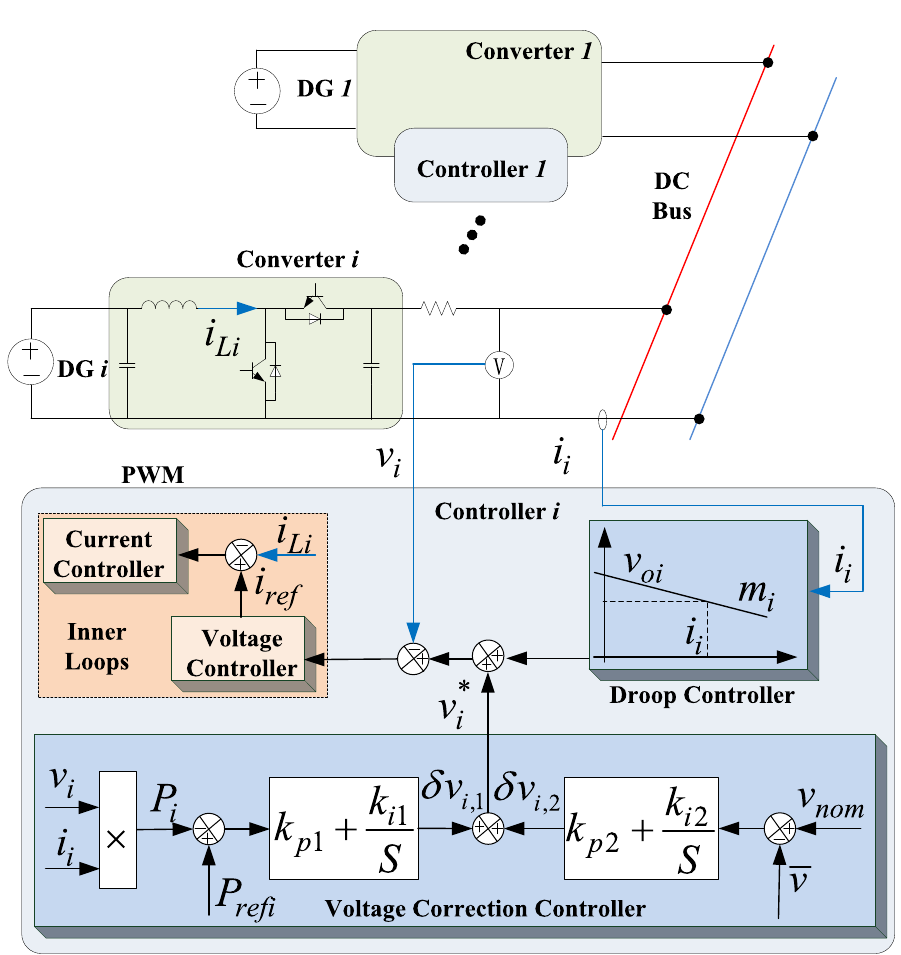
Figure 1. Proposed control diagram of converter-interfaced DGs in a DC microgrid.